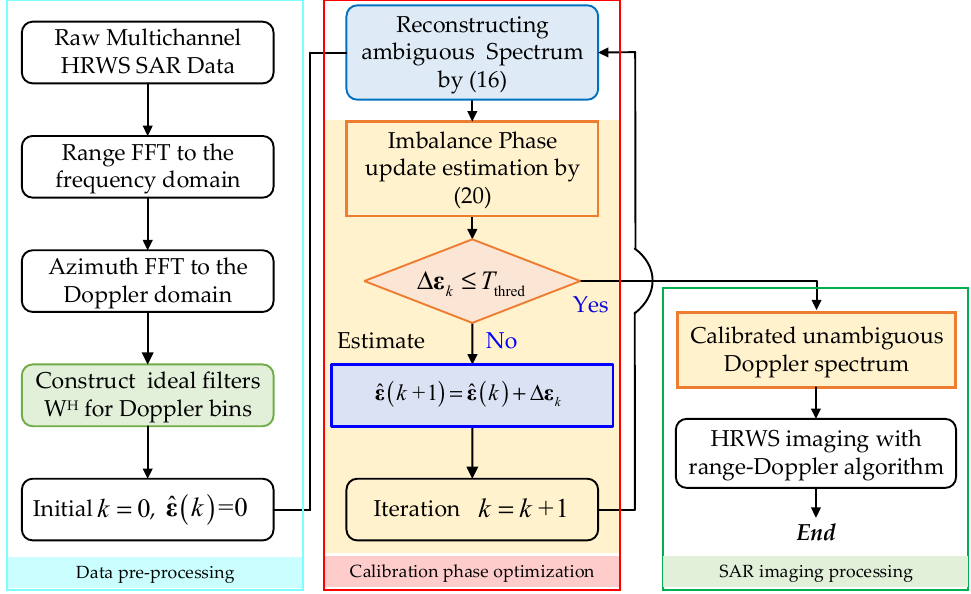
Figure 3. The flowchart of HRWS SAR imaging with phase calibration.